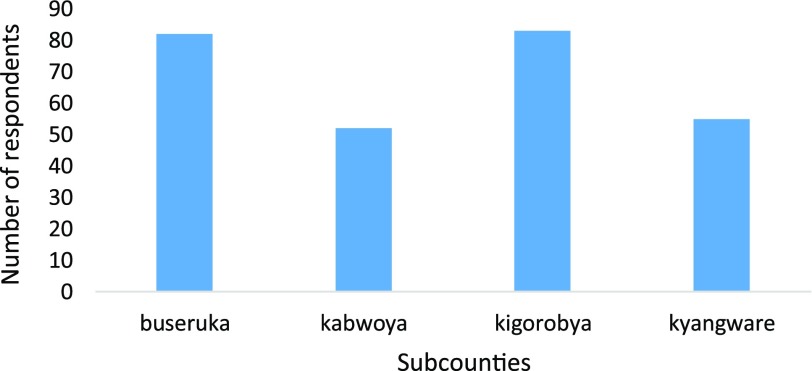
Distribution of study respondents in the four subcounties of Hoima district.